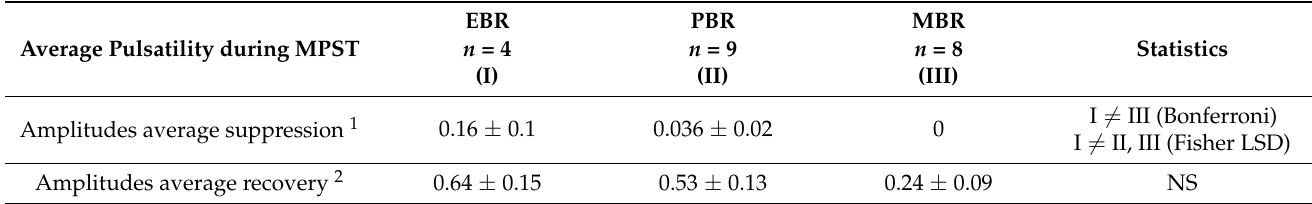
Table 2. Average pulsatility during MPST suppression and recovery. Data represent group mean ±